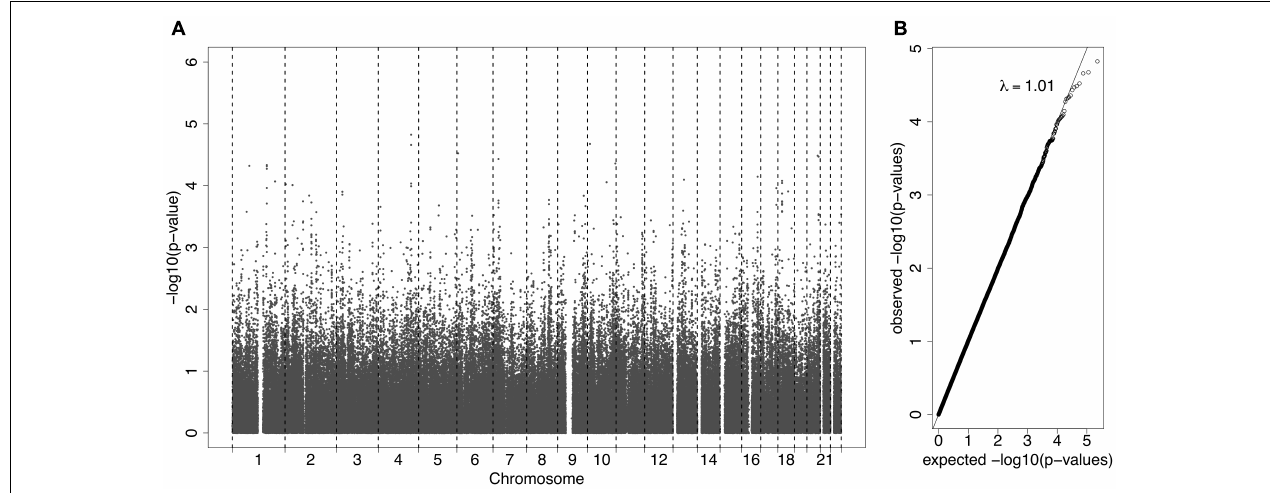
FIGURE 2 | (A) A Manhattan plot displaying the –log10( p -values) for the association between the phenotype ACR and the SNPs from the Affymetrix SNP Chip. (B) A QQ-plot, showing the observed p -values on the y -axis and the expected p -values on the x -axis under the null hypothesis of no association. TABLE 2 | The top eight hits in the GWAS study on the original cohort, along with the association results in the replication cohort. p -value in p -value of nearest p -value in Position (bp) Assoc. original SNP in original replication GRCh38.p12 allele Nearest gene sample sample sample